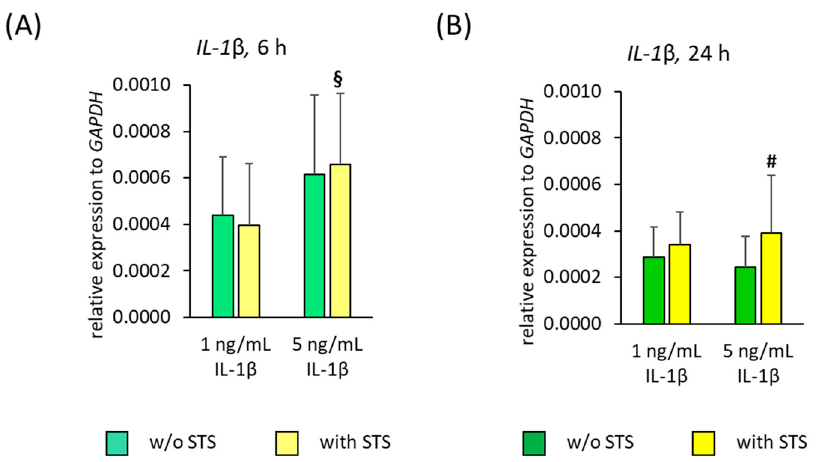
Figure 9. Effect of static orthodontic tensile forces on the IL-1 β -induced gene expression of IL-1 β in hPDL-MSCs in the presence of 2% FBS. STS with 6% equibiaxial elongation was applied to untreated or IL-1 β -treated hPDL-MSCs in the presence of 2% FBS. 6 ( A ) and 24 ( B ) hours after stimulation with or without STS, qPCR was performed showing the relative IL-1 β expression levels normalized to the internal reference gene GAPDH . All data are presented as mean ± S.E.M. # p -value ≤ 0.05 significantly higher compared to the appropriate IL-1 β stimulated cells without STS; § p -value ≤ 0.05 significantly higher compared to 1 ng/mL IL-1 β in the presence of